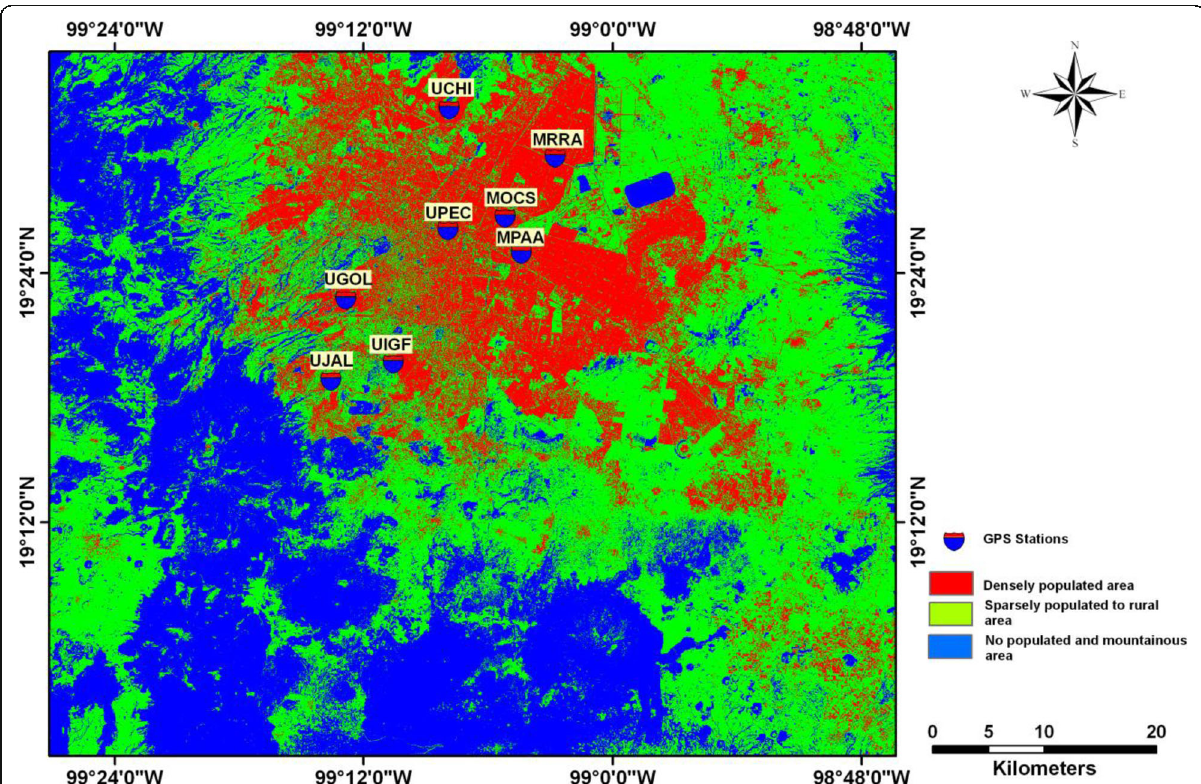
Fig. 7 SVM classification of the Mexico City area based on the Landsat ETM+ image from 15/11/2005 (red frame in Figure 2 refers to SVM ground